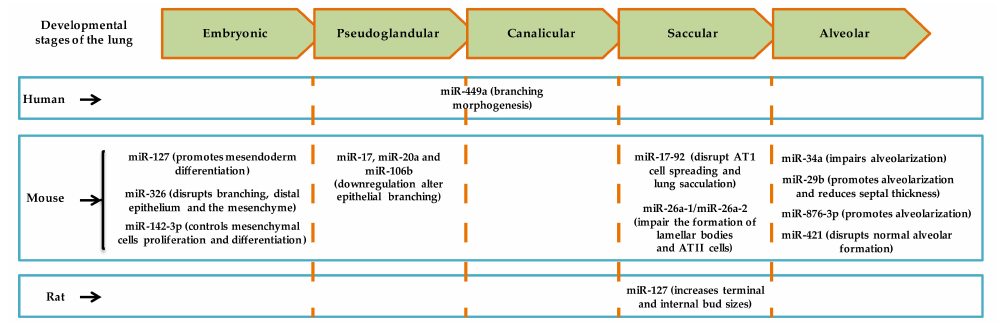
Figure 1. Summary of the role of miRNAs at various stages of human, mouse, and rat lung development as indicated in cited